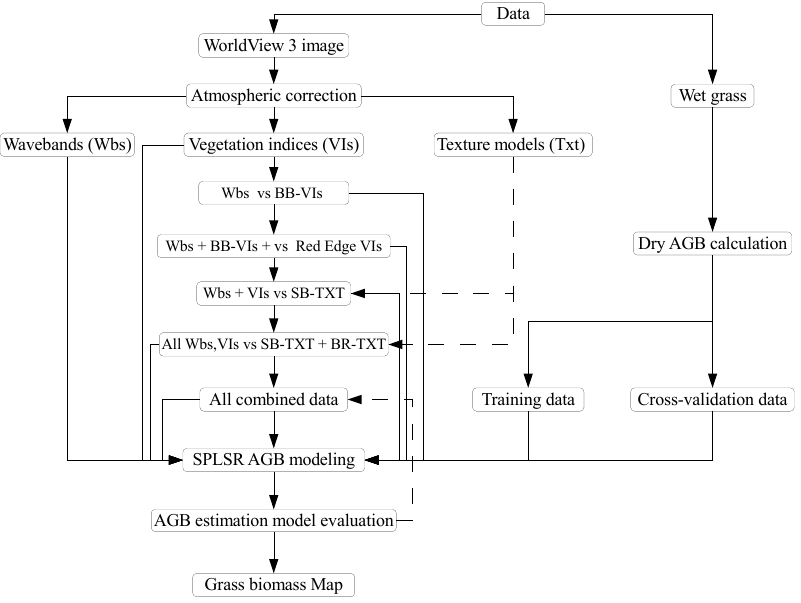
Figure 2. Flowchart illustrating stages in estimating above-ground (ABG) grass biomass in this study. Wbs represents WV-3 wavebands, VIs are vegetation indices, BB-VIs are broadband vegetation indices, SB-TXT represents single band texture models and BR-TXT represents band ratio texture models.